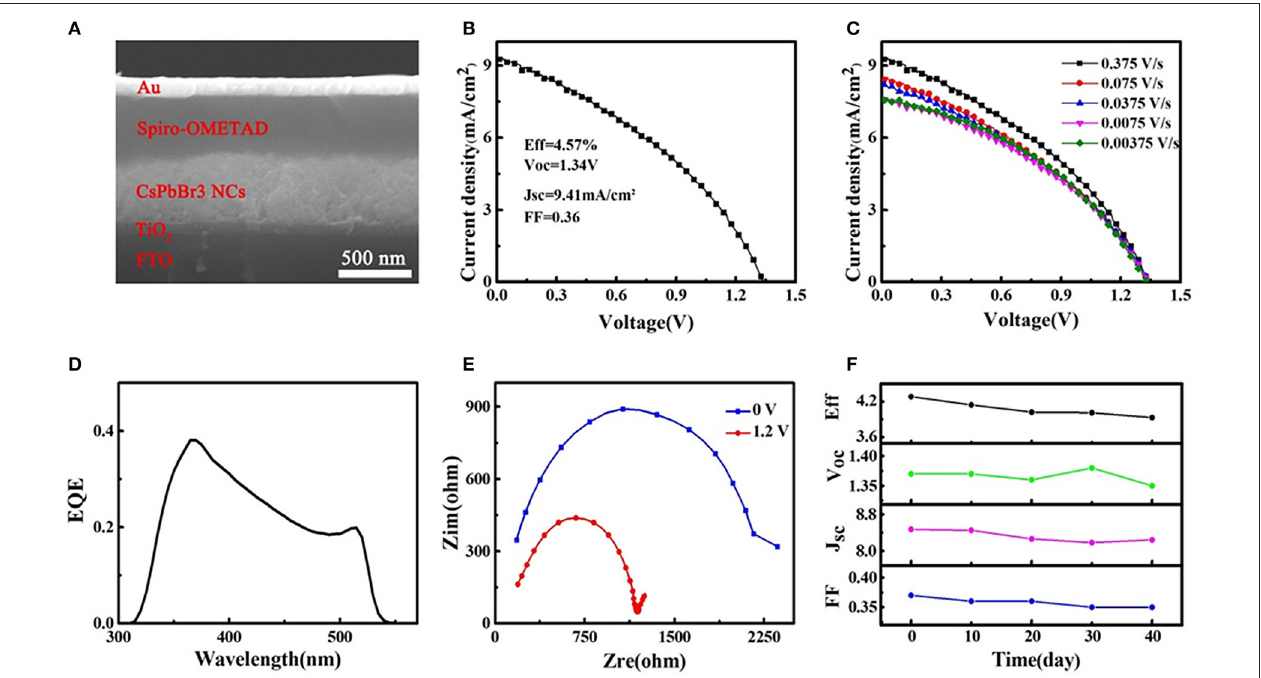
FIGURE 5 | CsPbBr 3 NC film photovoltaic device structure and performance. (A) Cross-sectional SEM images of device, (B) the current density-voltage curve of the best device under backward scan, (C) the current density-voltage curves obtained at different scan rate, (D) wavelength-dependent EQE curve. (E) Nyquist plots of